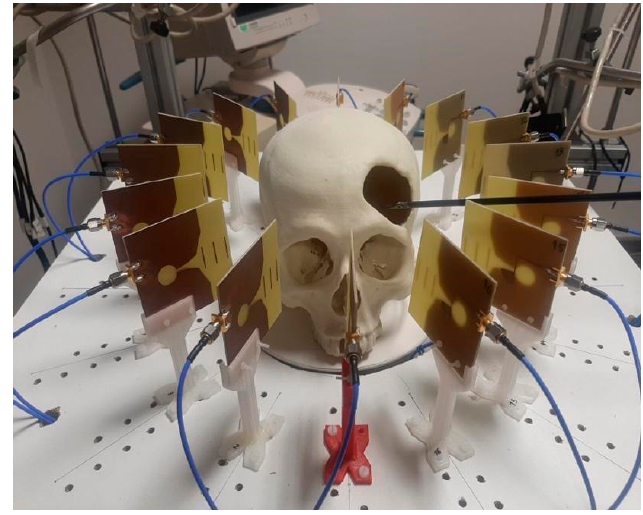
Figure 10. Experimental setup with the tool entering the cranium within the antenna